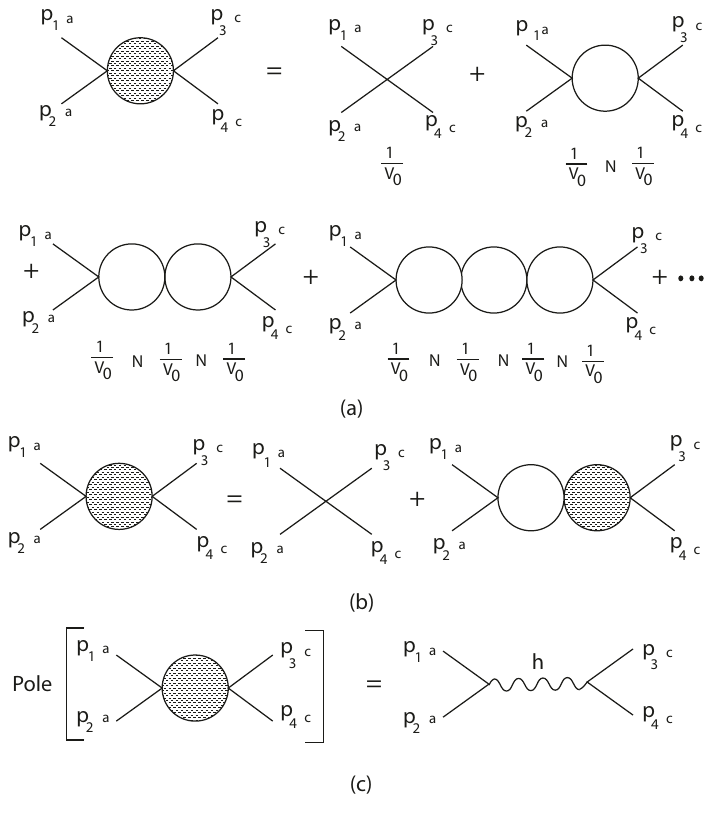
Figure 1 . Two-into-two scattering of (cid:30) bosons. (a) Diagrams that contribute at leading order in 1 =N , for the choice of external (cid:12)elds described in the text. (b) The equivalent recursive represen- tation. (c) The e(cid:11)ective graviton exchange